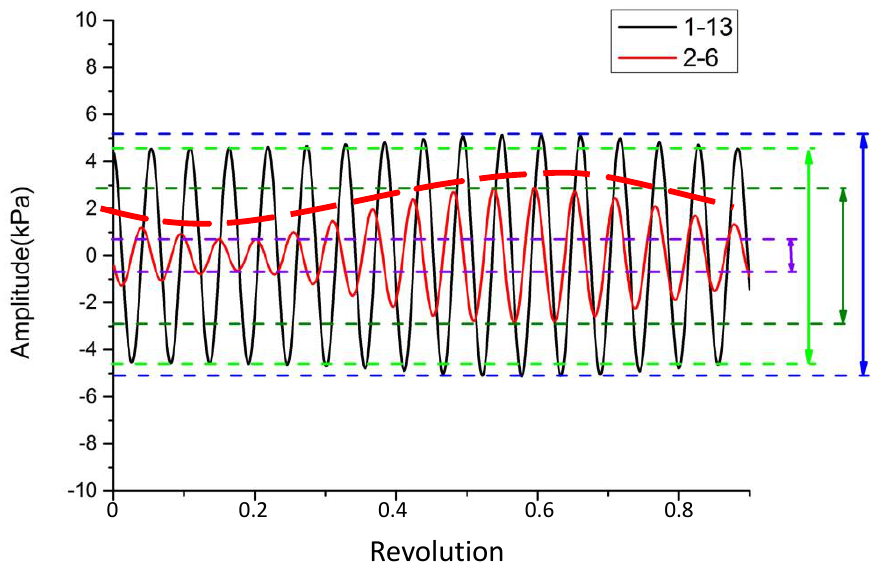
Figure 15. The comparison of the 1BPF disturbance of the R1 blade sweep between locations 1-13 and 2-6 .